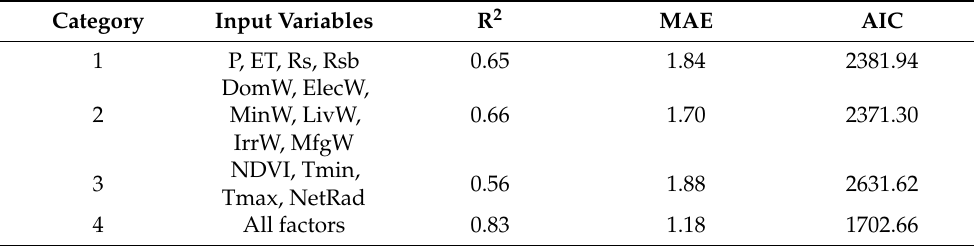
Table 3. List of fitting results of different input